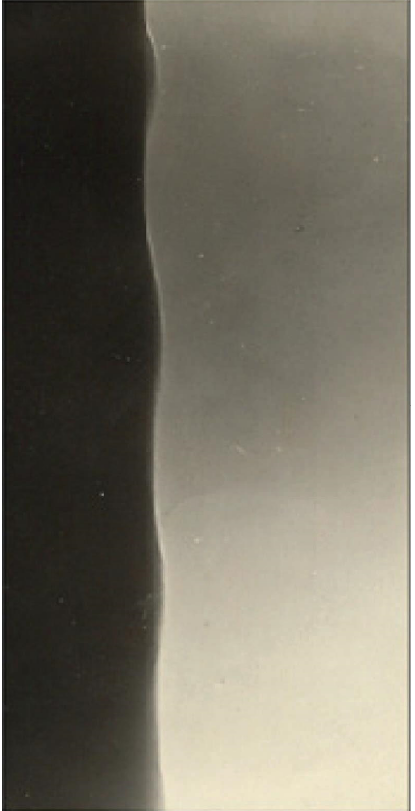
Figure 5: Te wavelike profle of the side surface of the Si NWs ( × 13700).